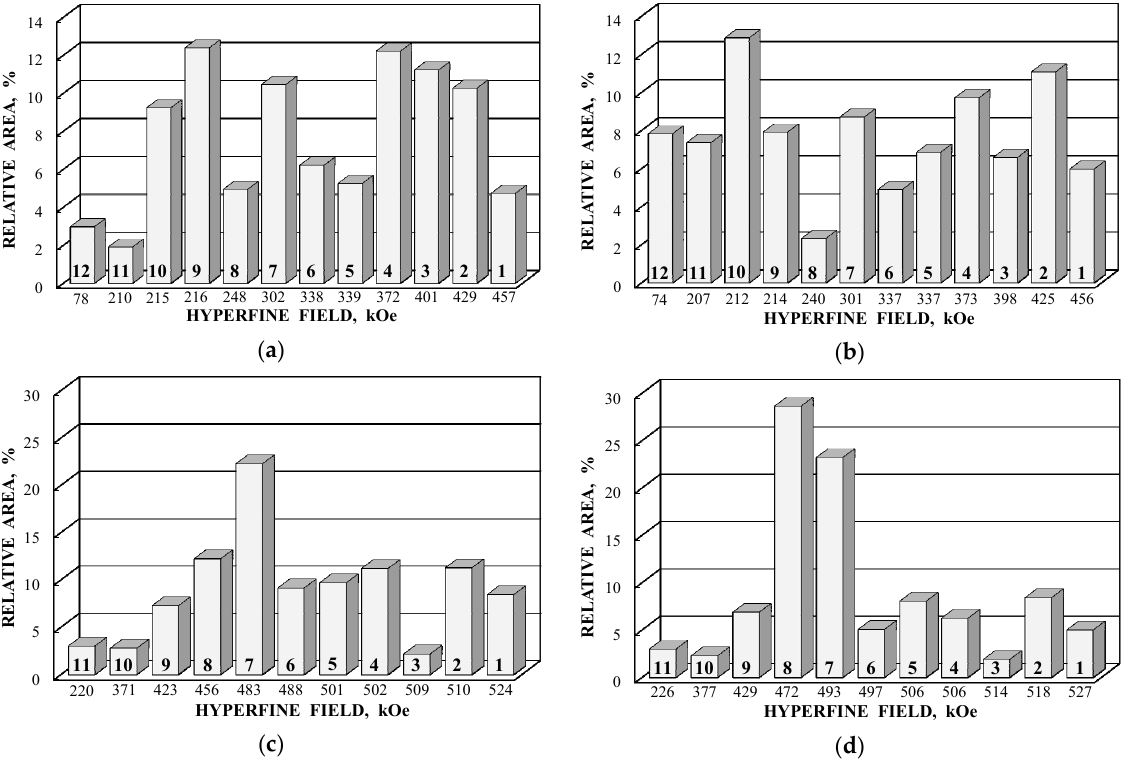
Figure 37. Histograms of the distributions of the relative areas of magnetic sextets in the order of increase in the H eff values for corresponding spectral components of the as ‐ prepared γ‐ Fe 2 O 3 ( a , c ) and γ‐ Fe 2 O 3 –DMSA ( b , d ) samples at 295 K ( a , b ) and 90 K ( c , d ) (the numbers of sextets are the same as indicated in Figure 36). Adapted from Ref. [72] with permission from Elsevier: Spectrochimica Acta, Part A: Molecular and Biomolecular Spectroscopy, Vol. 152, Oshtrakh M.I., Ushakov M.V., Šepel á